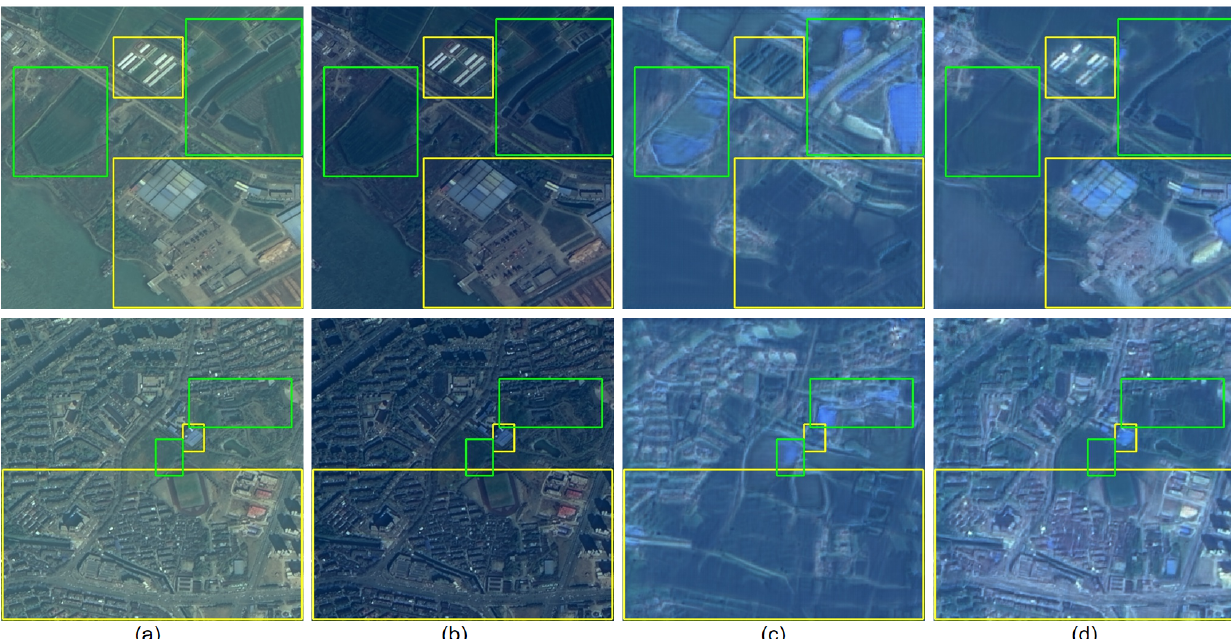
Figure 13. GF-1 to GF-1B: Original GF-1 images and the transformed images which are used to train the classifier for GF-1B images. ( a ) GF-1 images. ( b ) Color matching. ( c ) CycleGAN. ( d ) BiFDANet (ours).